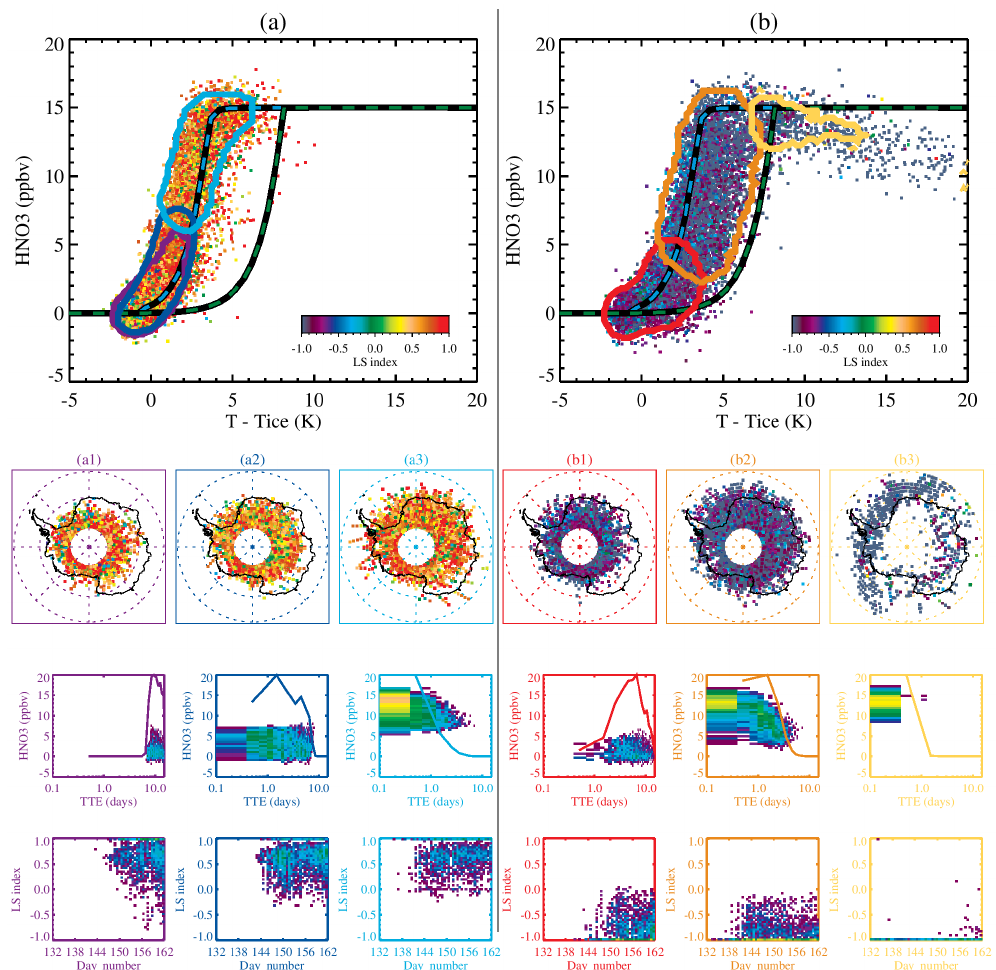
Figure 16. Results of the K = 6 cluster analysis of the combined MLS and CALIOP data for the Antarctic for the years 2006–2015 at 32hPa. Thermodynamic diagrams indicate for reference the theoretical HNO 3 uptake by STS (blue–black dashed line) and by NAT (green–black dashed line). The scatter plots show the MLS HNO 3 vs. temperature relative to the ice frost point colored by the corresponding LS_index obtained from CALIOP. Column a ( b ) shows the data in three groups a1 – a3 ( b1 – b3 ), which are seen to be predominantly liquid (solid) PSC detections according to the LS_index . The colored contours ( a1 – purple, a2 – dark blue, a3 – light blue, b1 – red, b2 – orange, b3 – yellow) contain 95% of the corresponding cluster members. The maps show the geographic distribution of the members of each of the clusters and are color-coded by the LS_index (inset color bar). A 2-D view (HNO 3 vs. TTE) is provided of the cluster densities (purple– yellow shading indicates low to high density) and the accompanying colored solid lines represent the normalized 1-D histogram of the TTE values. The cluster densities are also displayed as a 2-D view of LS_index vs. day number. Table 3. Results of the K = 6 cluster analysis for 2006–2015: the number of members assigned to each group, the mean and standard deviation of the relative number of observations, and the centroids in the four-variable data space are given. Group LIQ/SOL Number